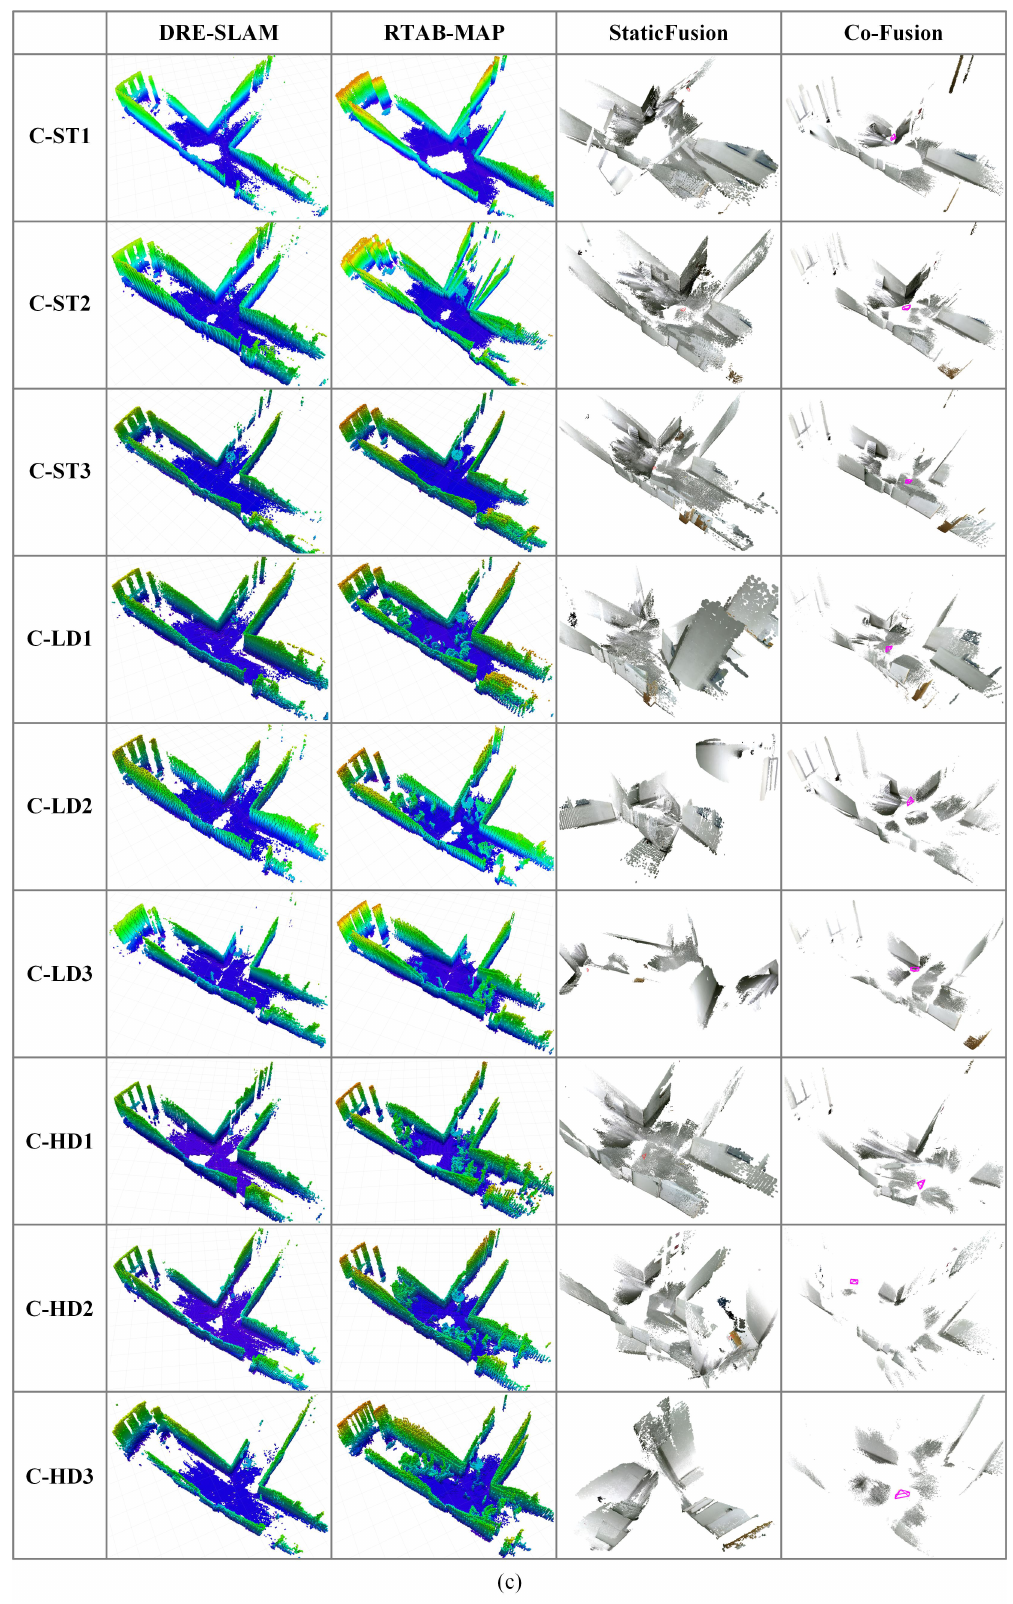
Figure 11. Maps obtained by the four methods in the ( a ) office, ( b ) lab, and ( c ) corridor environments. The red circles show the deformation and the dynamic data introduced in the OctoMaps created by